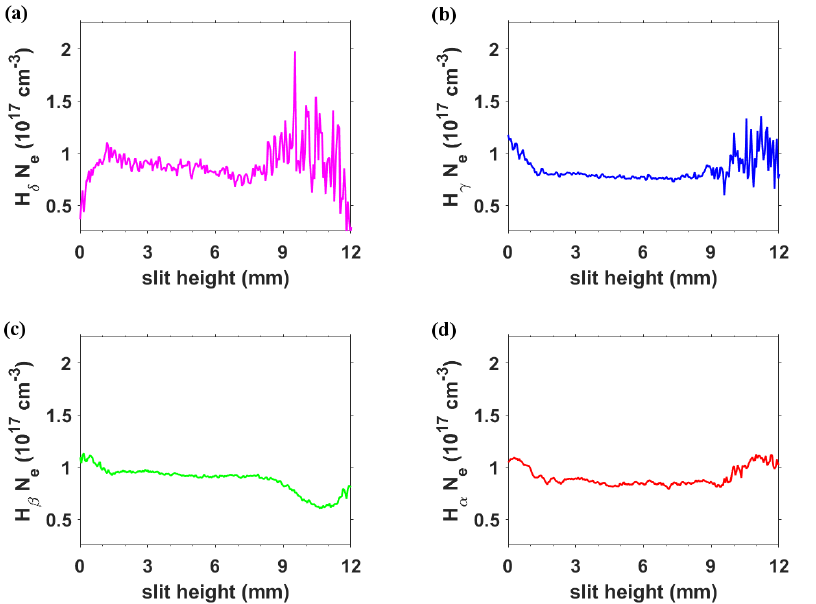
Figure 12. Electron density from line-of-sight data displayed in Figure 2 at τ = 1.5 µ s, 0.025- µ s gate. ( a ) H δ , ( b ) H γ , ( c ) H β , and ( d ) H α .